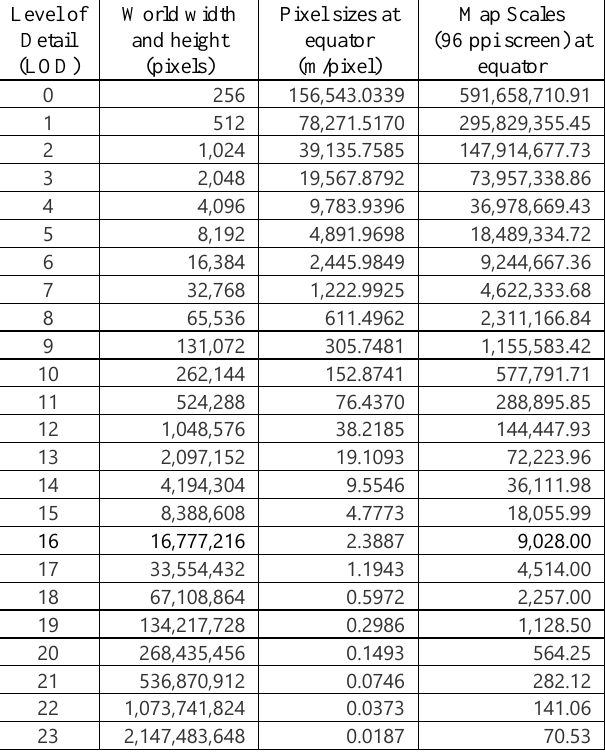
Table 13. Pixel sizes and map scales at equator for Web Mercator Tiling